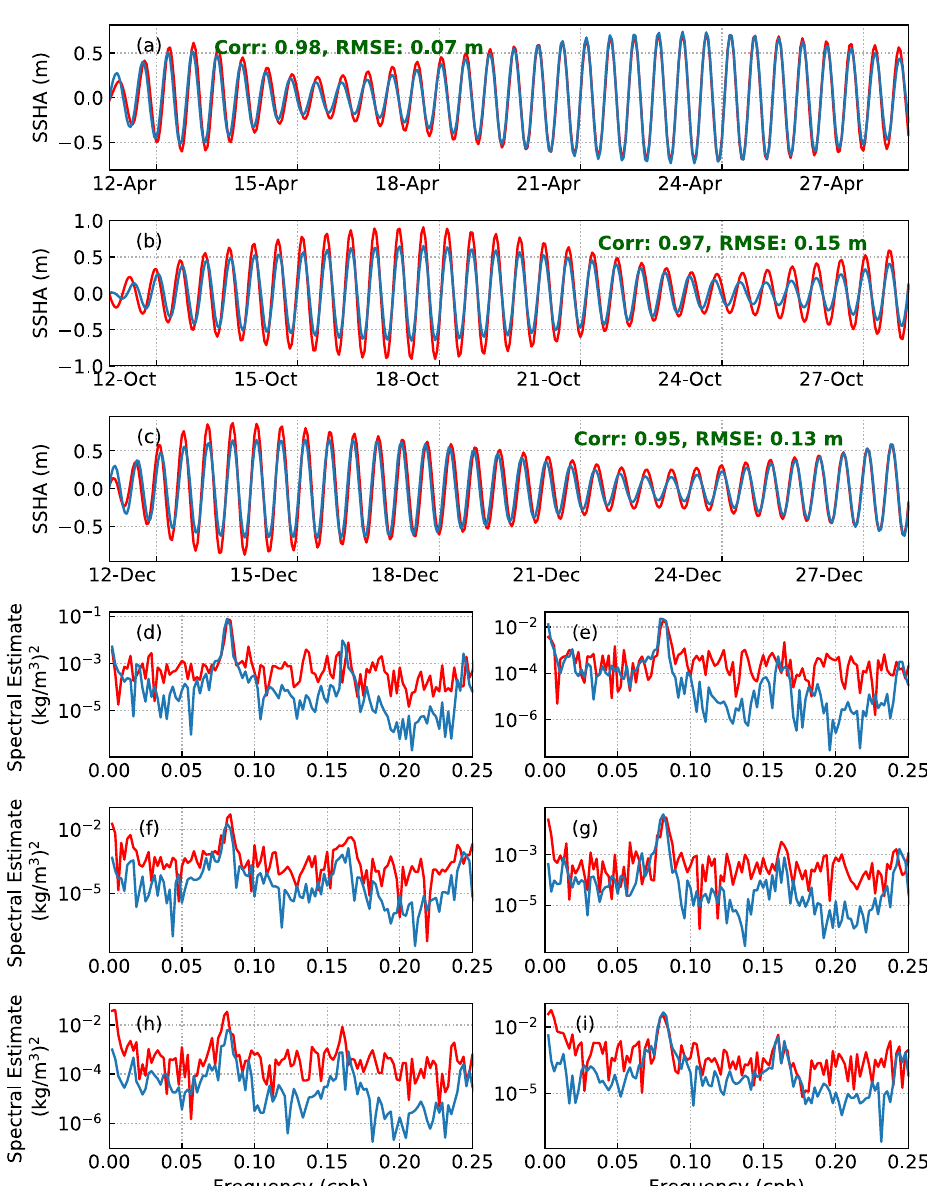
Figure 4. Comparison of model-simulated sea surface elevation anomaly with tide-gauge data at Sabang (5.88°N, 95.31°E) during ( a ) April 2016, ( b ) October 2016, and ( c ) December 2016. Comparison of the density spectral estimate between observations from BD12 and model simulations at ( d , f , h ) 75 m and ( e , g , i ) 100 m depth during ( d , e ) April 2016, ( f , g ) October 2016, and ( h , i ) December